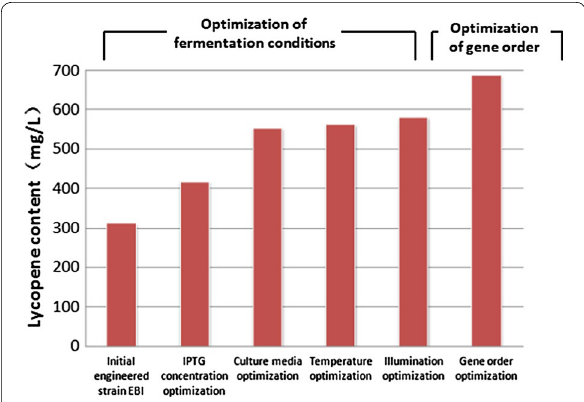
Fig. 9 Lycopene production was improved by the combined optimization of culture conditions and gene order. The E. coli strain EBI produced a high content of lycopene after twin optimization of fermentation conditions and gene expressing